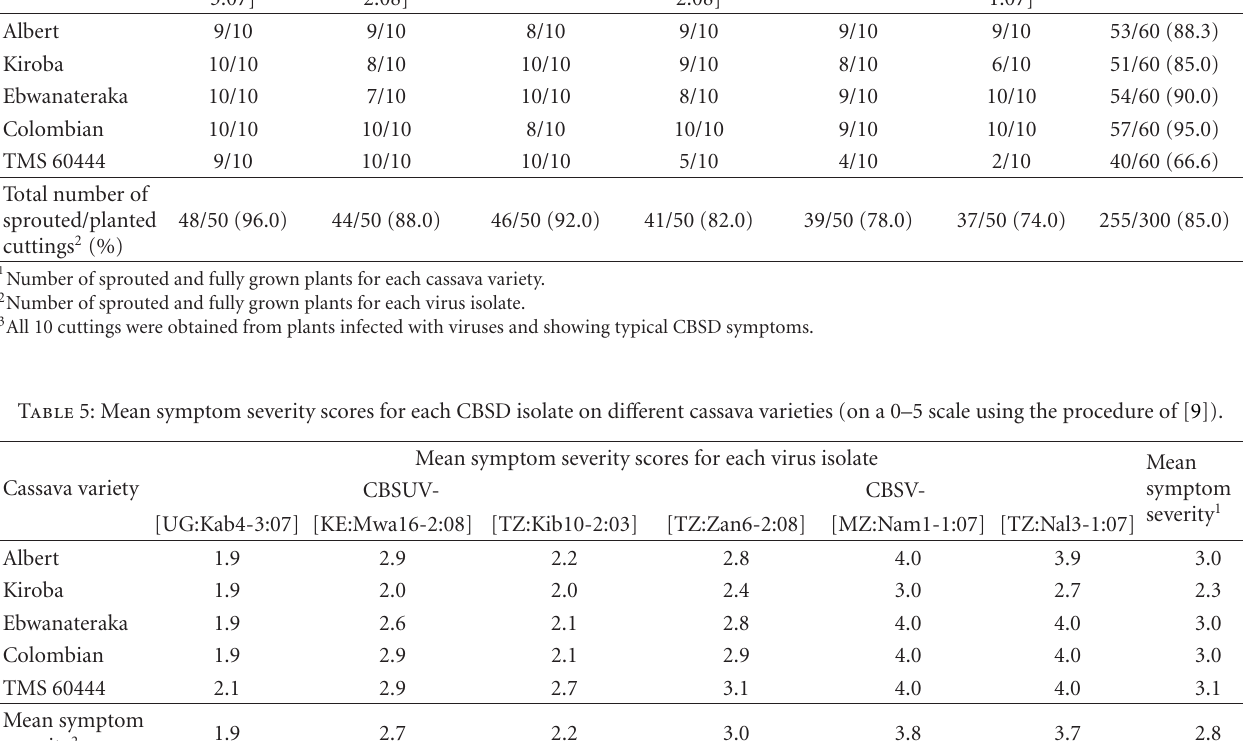
(Table 2). All plants of N. clevelandii were infected with each isolate. Most but not all plants of N. tabacum nn,